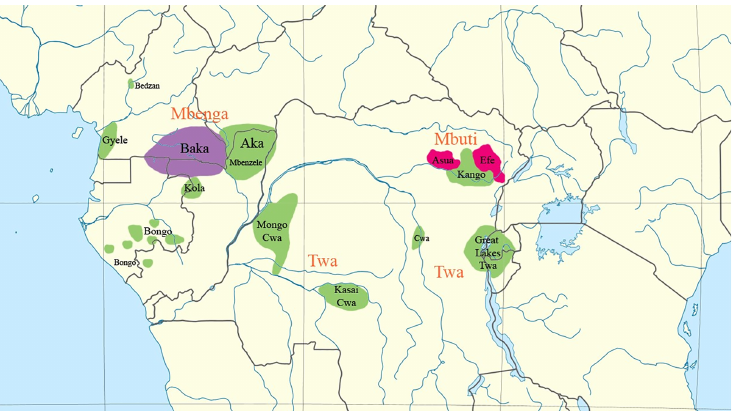
Fig 1. Distribution of Pygmies and their languages according to Bahuchet (2006). Green: Bantu, purple: Ubangian, red: Sudanic. This file is licensed under the Creative Commons Attribution-Share Alike 3.0 Unported license.